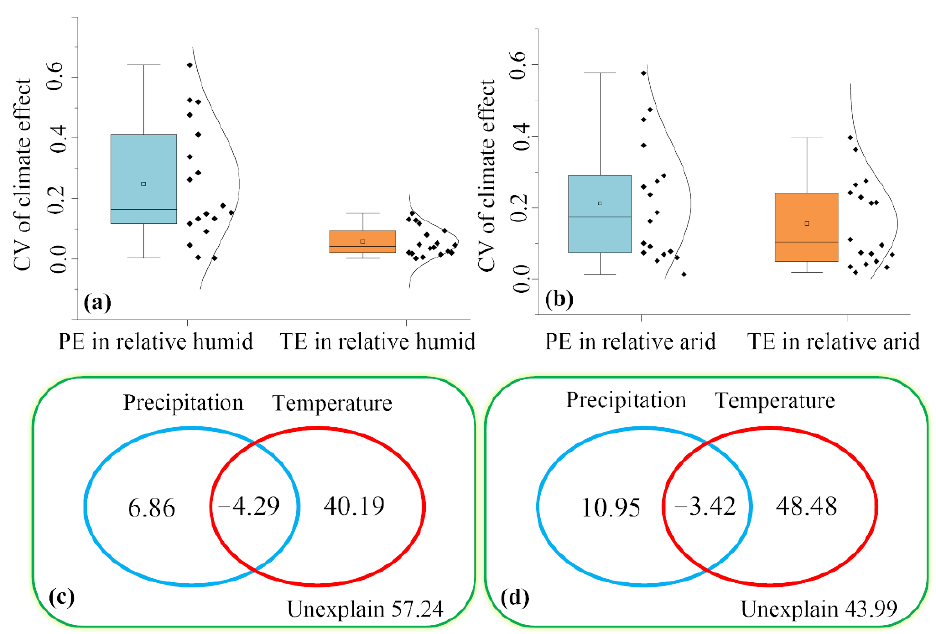
Figure 7. The inter-annual variable coefficients of the effects of precipitation on the NPP and tem- perature on the NPP in relatively humid regions ( a ) as well as in relatively arid regions ( b ); the contribution rates of precipitation and temperature on the NPP in relatively humid regions ( c ) as well as in relatively arid regions ( d ), respectively.